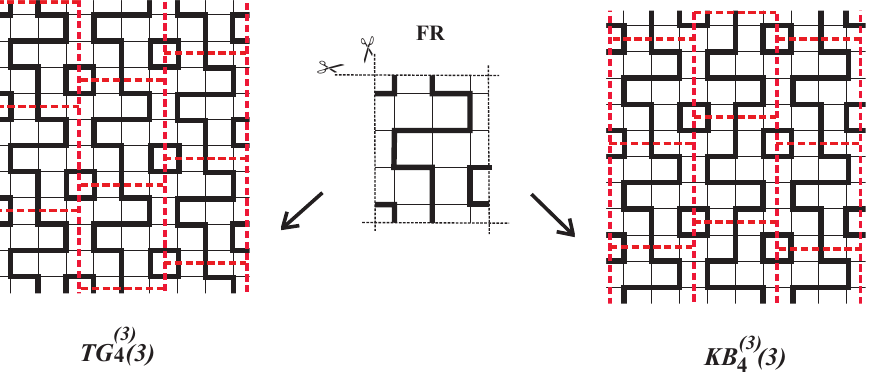
( 3 ) ( 3 ) ( left ) and RI of a 2-factor for KB ( 3 ) 4